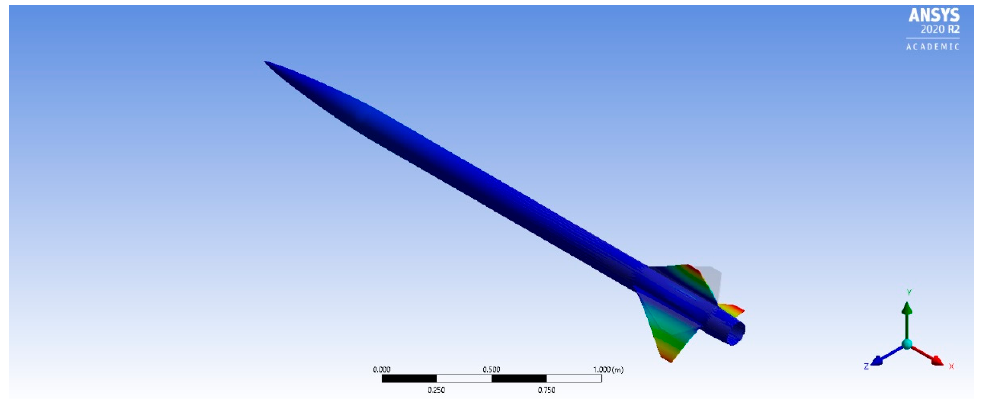
Figure 31. Pure Radial Mode Shape (X–Z Plane).